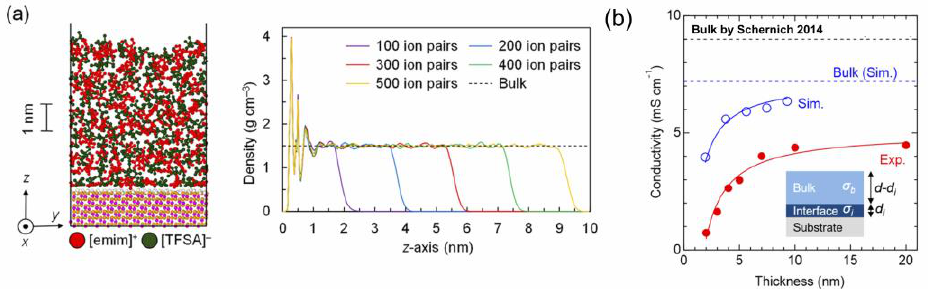
Figure 6. ( a ) Molecular dynamics calculations of thin film IL [emim][TFSA] for various thicknesses in contact with a solid substrate of sapphire. ( b ) The thickness dependence of ionic conductivity for IL thin films experimentally obtained (red filled circle), together with the simulated result by the molecular dynamics calculation (blue open circle). The dashed black line is the bulk conductivity [31]. Reproduced with permission from ref. [29]. Copyright 2018, American Chemical Society.